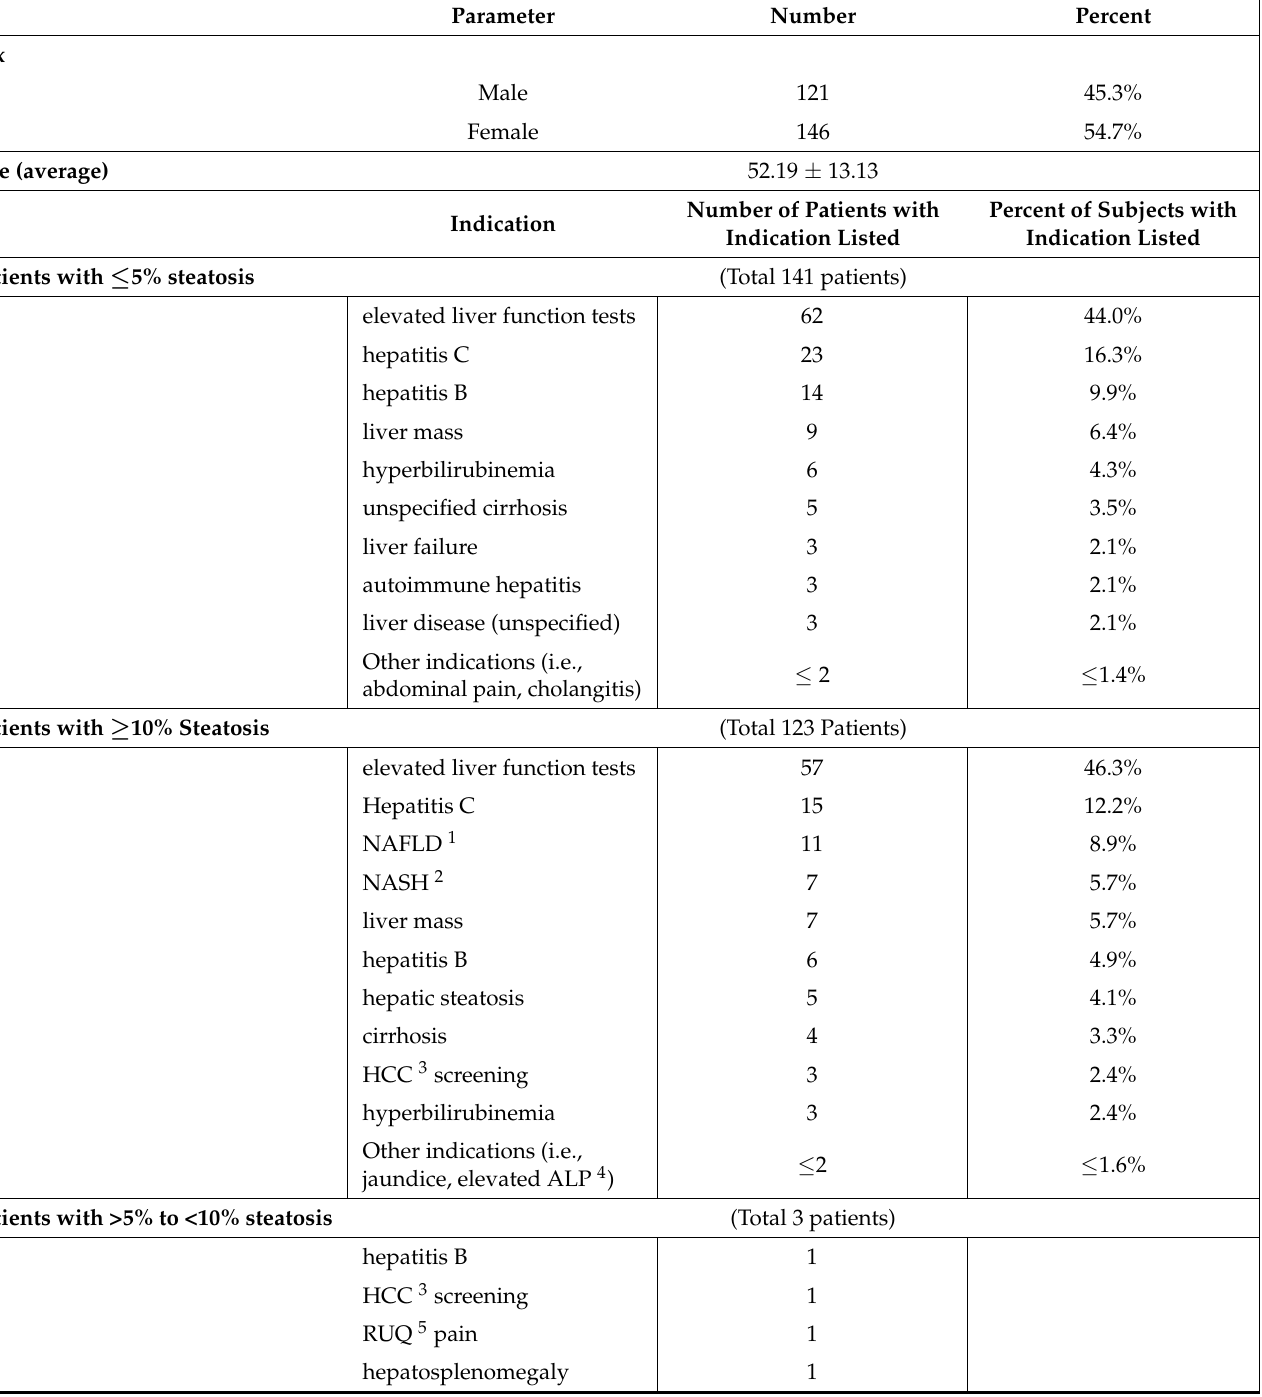
Table 1. Patient demographics and exam